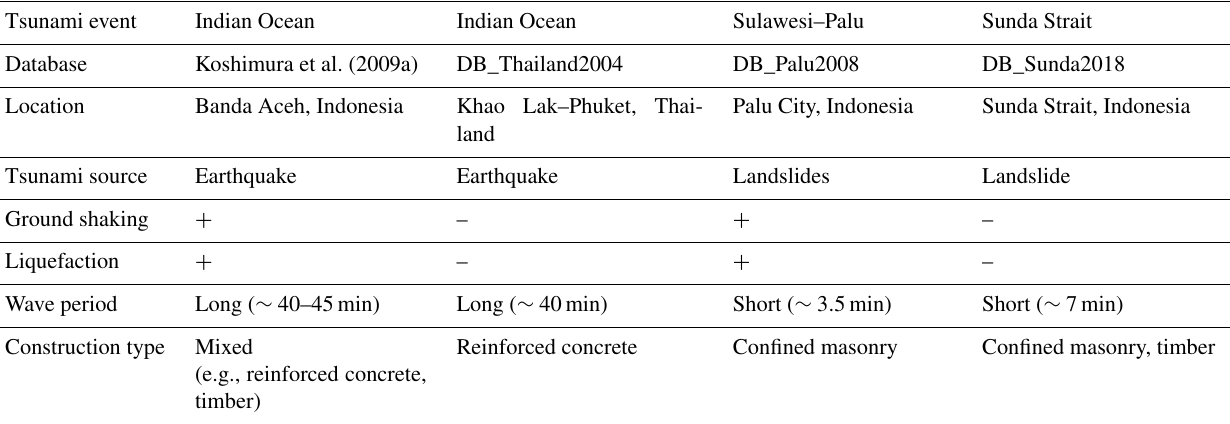
Table 11. Characteristics of the 2004 Indian Ocean tsunami in Banda Aceh (Indonesia) and Khao Lak–Phuket (Thailand), as well as the 2018 Sulawesi–Palu and 2018 Sunda Strait